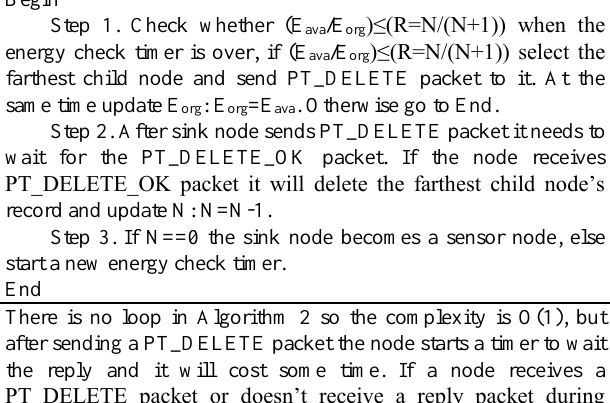
Algorithm 2. Check energy consumption of sink node